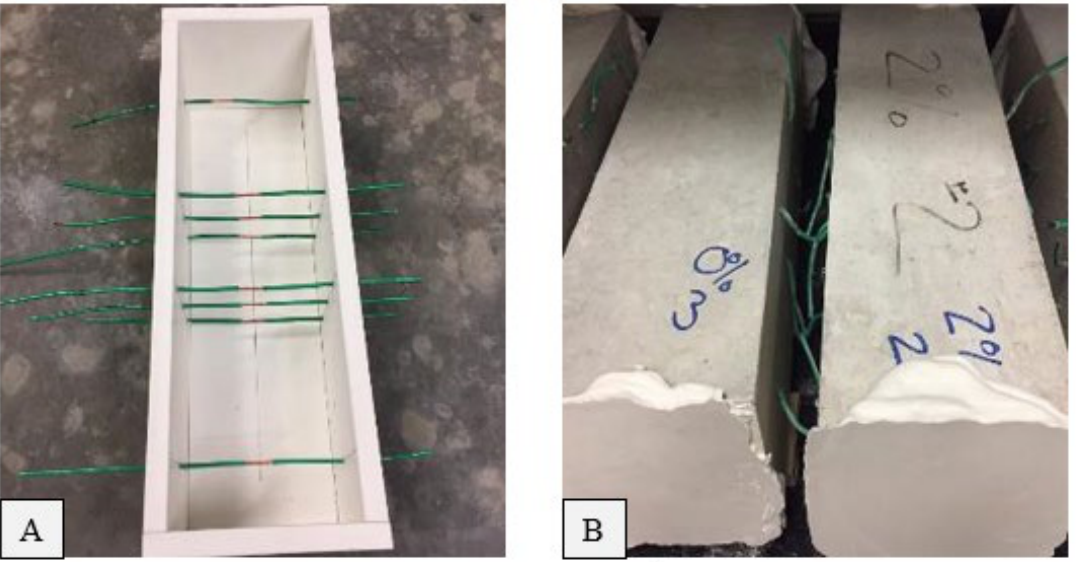
Figure 3. Specimen mold for columns ( A ) and demolded columns with plaster caps ( B ) (Photo credit: D. B. Scott).